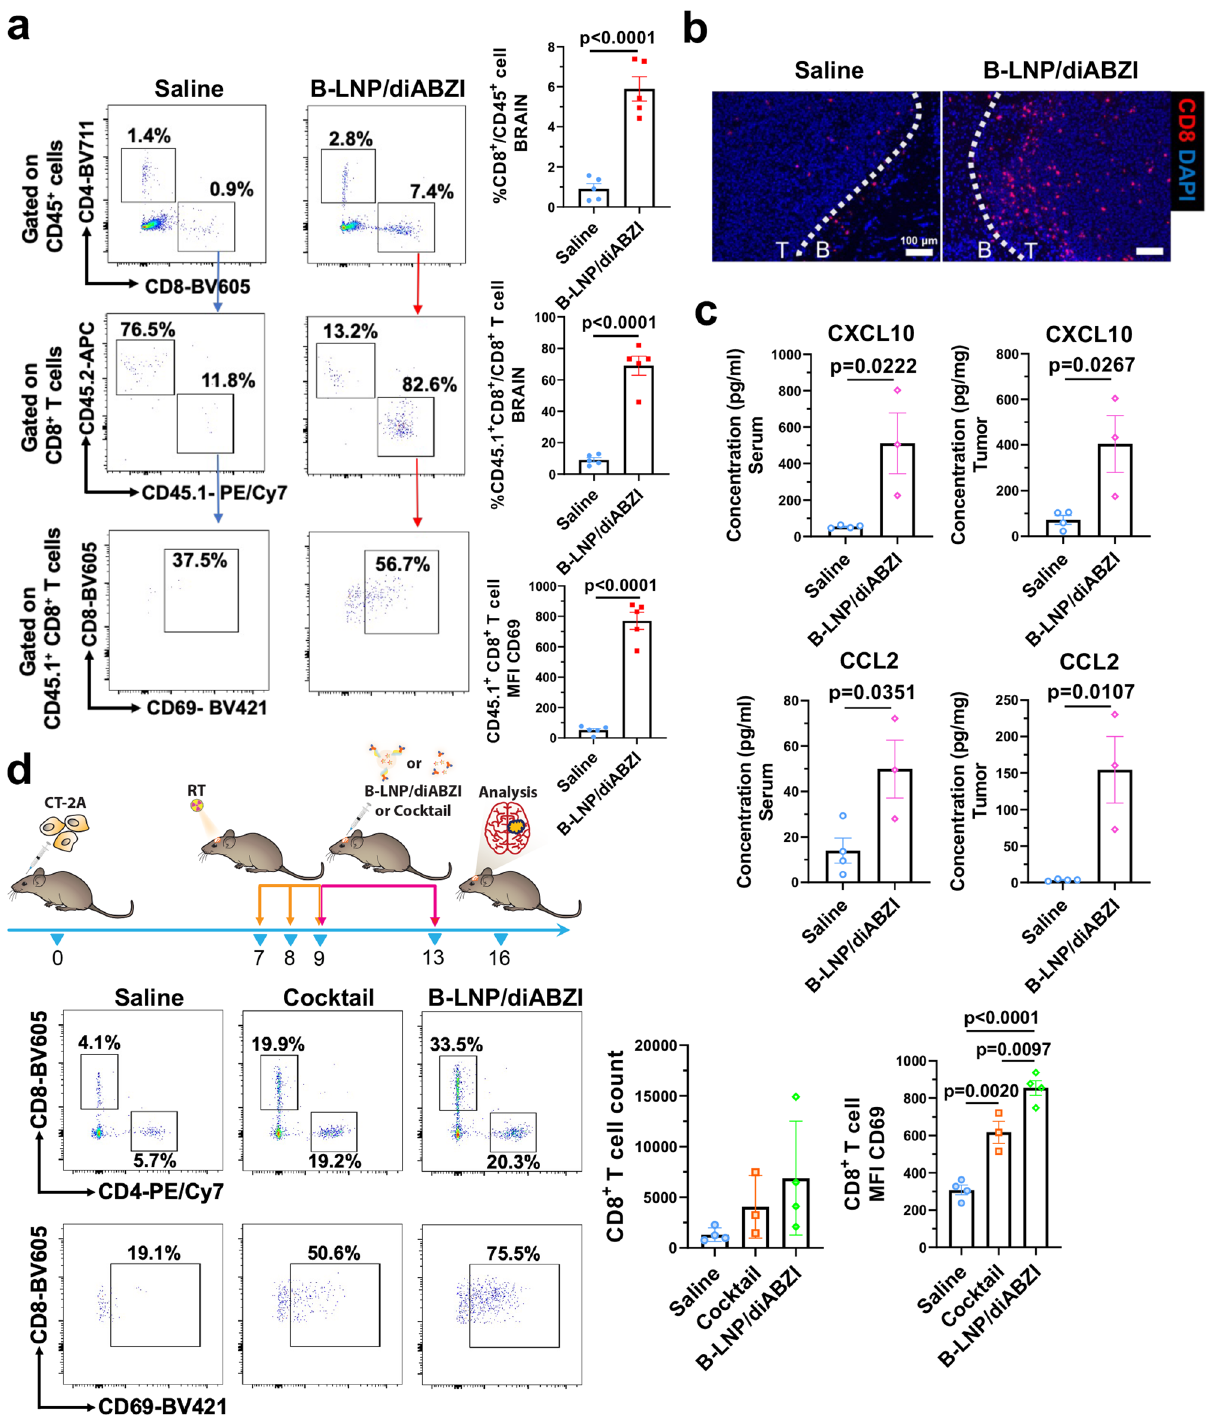
Fig. 6 | Therapeutic reprogramming of TAMC enhances CD8 + T cell in fi ltration and activation in murine gliomas. a CD45.1 + CD8 + T cells were adoptively trans- ferred through intravenous administration to CT-2A tumor-bearing C57 mice receivedradiotherapy(RT)followedbysalineorB-LNP/diABZI(0.25mg/kgdiABZI) treatmentthroughanintracraniallyimplantedcannula.CD45.1 + cellswereanalyzed by fl owcytometry in tumor-bearing brains ( n =5 mice). T cell activation status was assessed by CD69 expression. A representative animal for each group is shown. b CD8 + Tcellbrainlocalizationwasdemonstratedbyimmuno fl uorescencestaining. Dotted line indicates the border of normal brain (B) and tumor site (T). Scale bar, 100 μ m. The experiment was carried out twice independently. c MSD multiplex cytokine analysis of serum and brain tumors collected from CT-2A-bearing